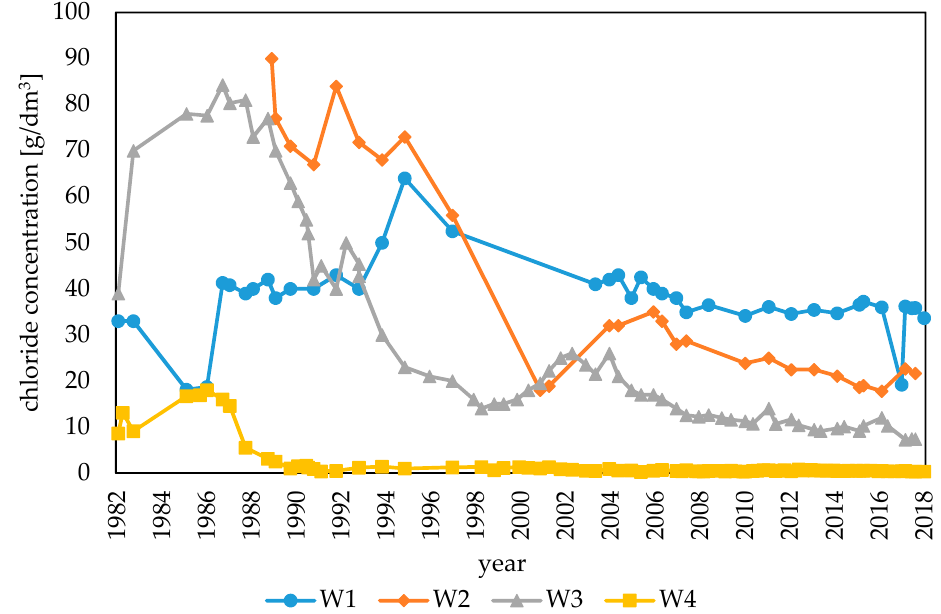
Figure 6. Concentration of chloride ions in groundwater collected from piezometers located around sedimentary ponds. Source: own study .